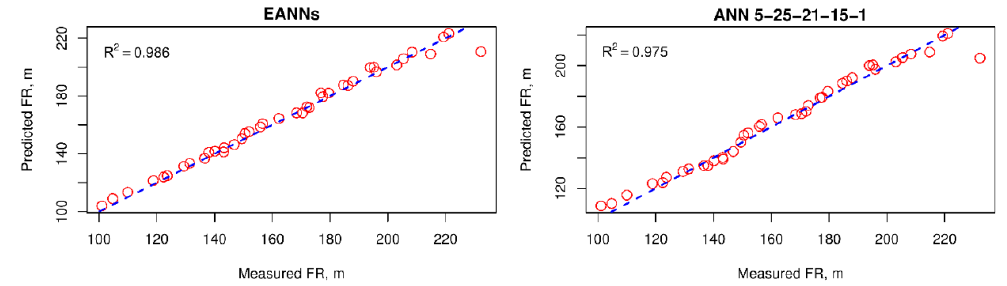
Figure 9. Comparison of the proposed EANNs and ANN models with the same structure.